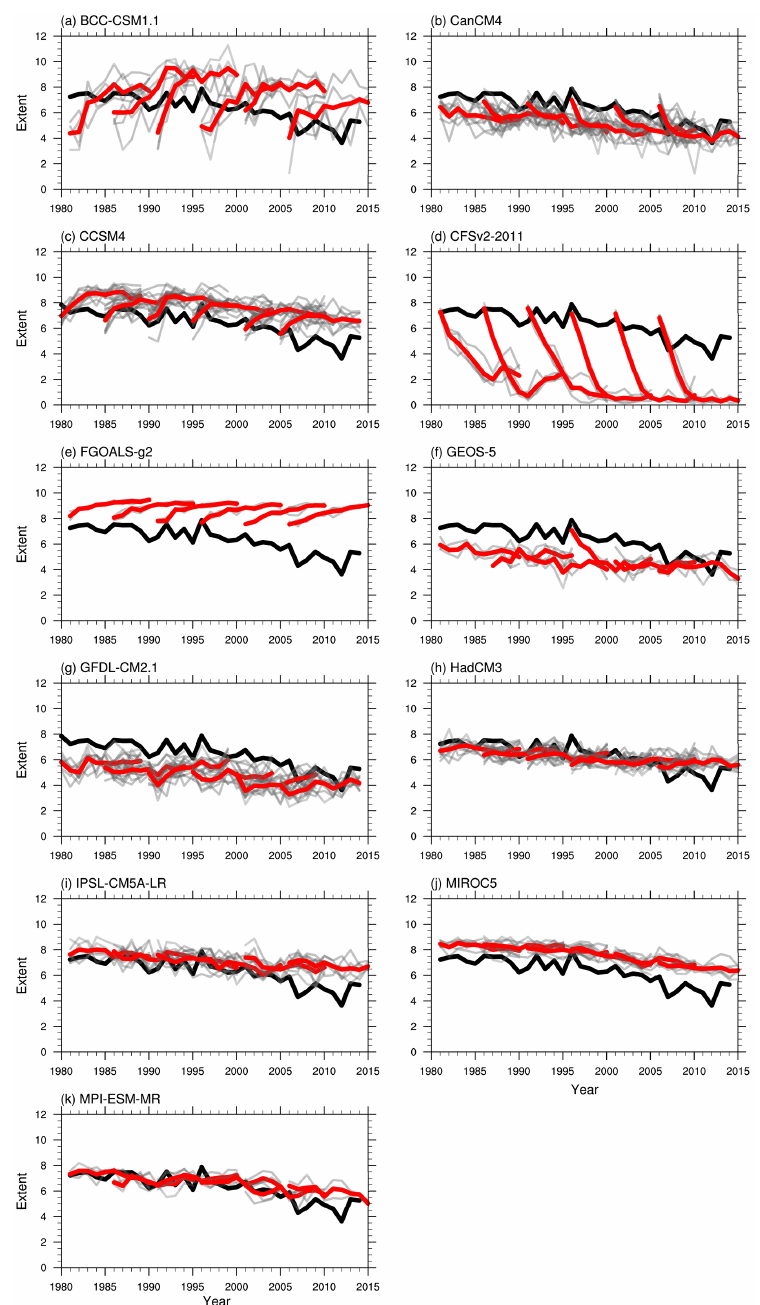
Figure 2. Time series of September Arctic sea ice extent (seasonal minimum) from the simulations of the 10-year hindcast for each ensemble member of each individual model (thin gray line), the ensemble mean of each individual model (thick red line), and satellite observation (black line) from 1981 to